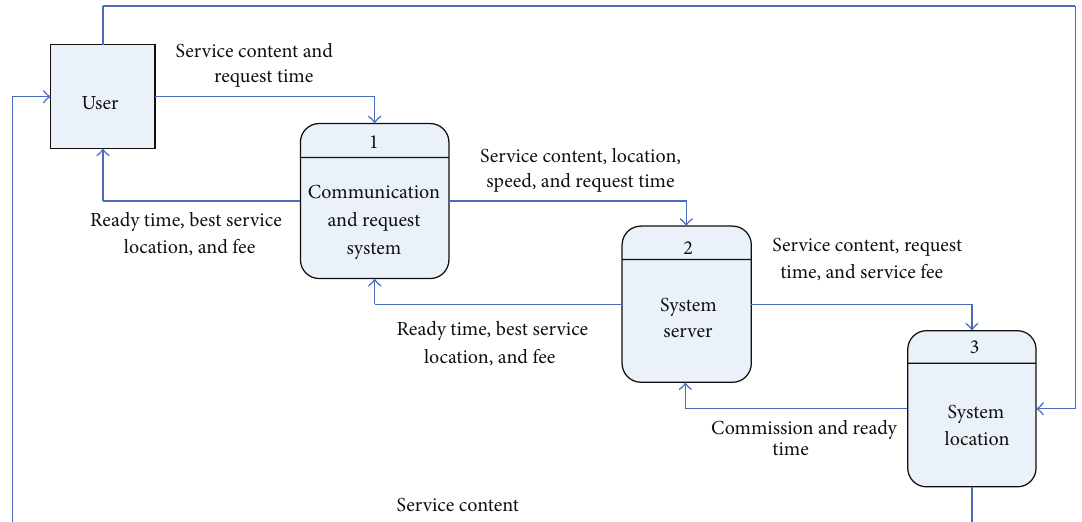
Figure 3: The DFD of the intelligent